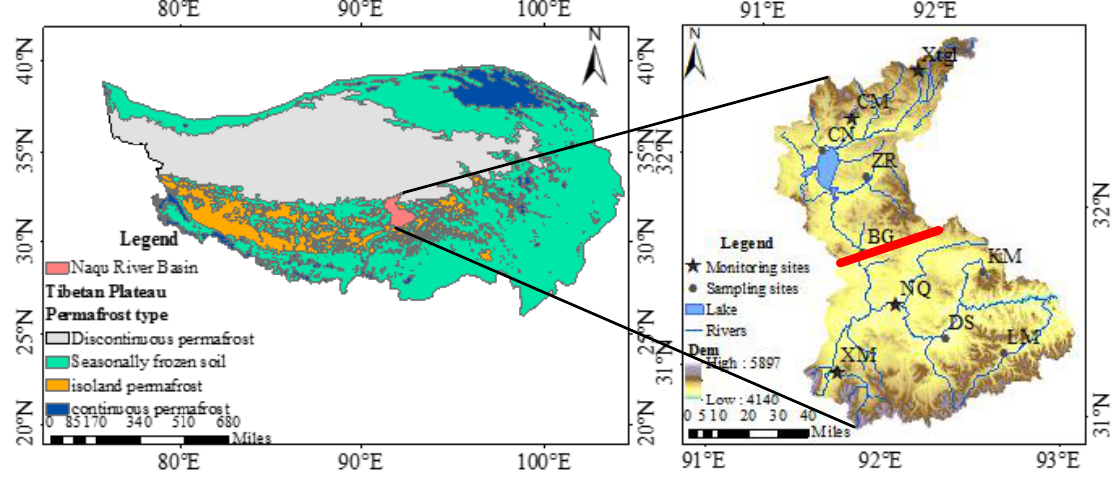
Figure 2. The location map of the Nagqu Basin. The star-shaped points are the monitoring sites, and the dots are the sampling sites. The different colors in the ( left ) figure represent different types of frozen soil, and the different colors in the ( right ) figure represent different elevations .